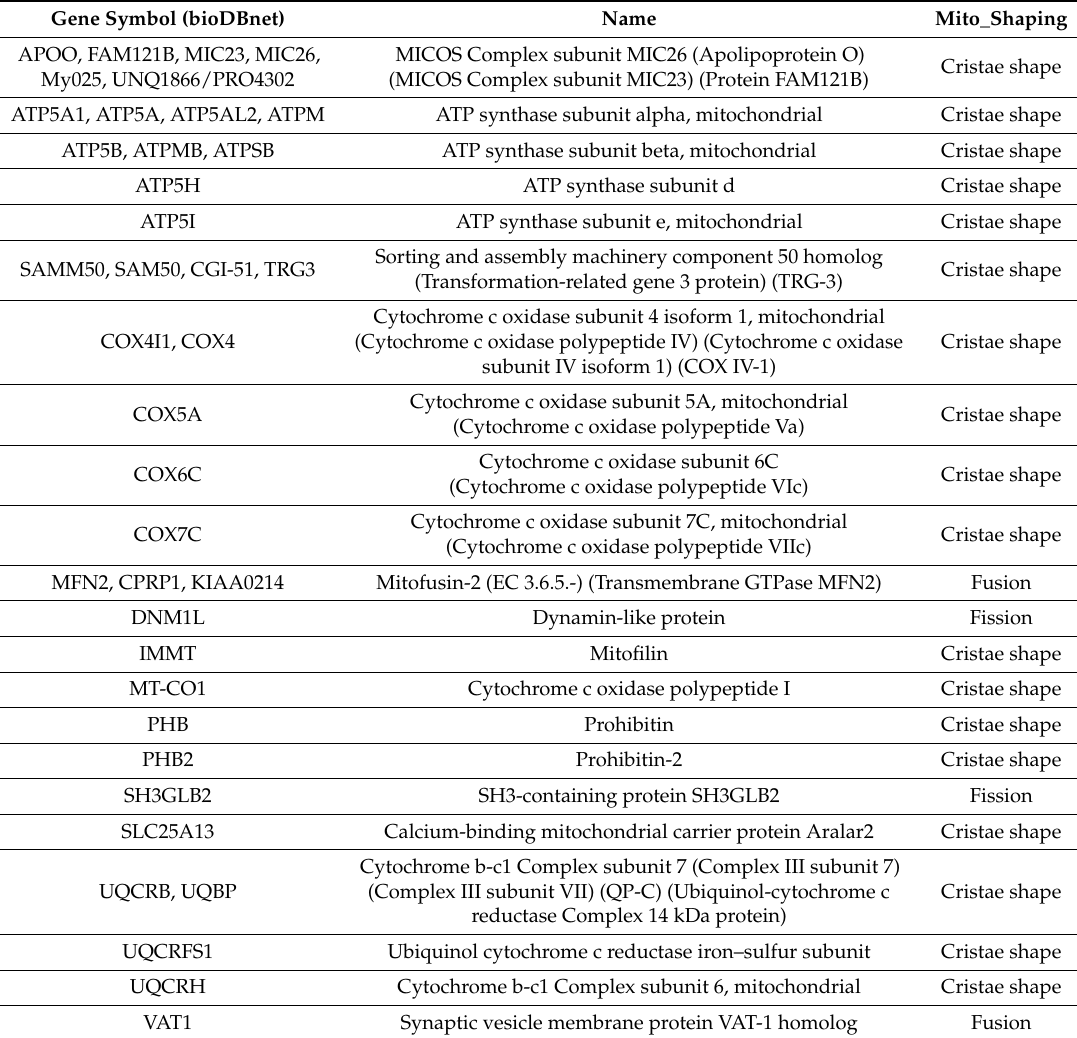
Table 2. List of mitochondrial-shaping proteins found to be modified in Parkinson’s disease.